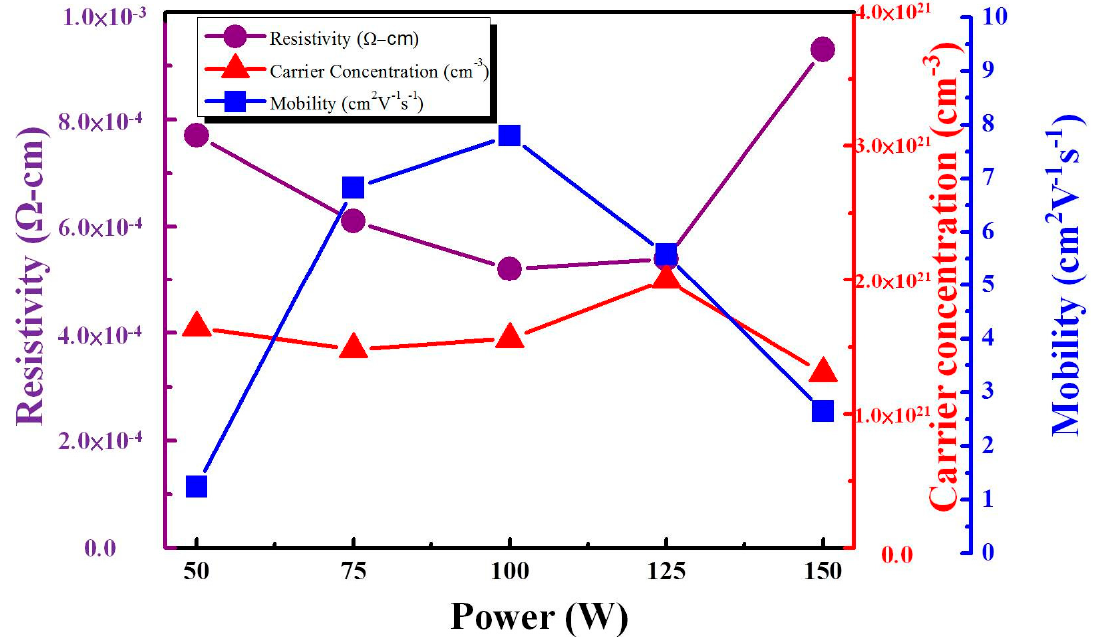
Figure 4. Electrical resistivity, carrier concentration, and mobility of IZTO films with various sputtering powers.